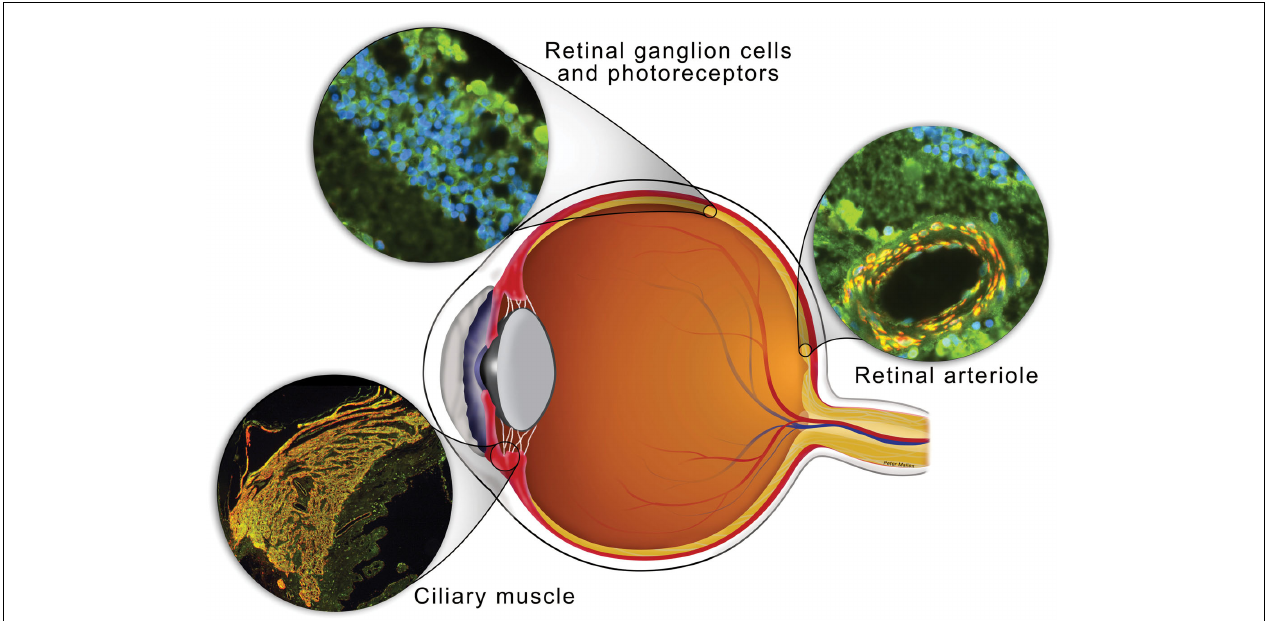
FIGURE 2 | Schematic of the eye with anatomical sites relevant for the development of POAG in which sGC is expressed indicated. Sections through retinal ganglion cells, ciliary muscle and a retinal arteriole from a human eye were stained for sGC α 1 (green), α -smooth muscle actin (red), and/or DAPI nucleic acid stain (blue). Both sGC α 1 and